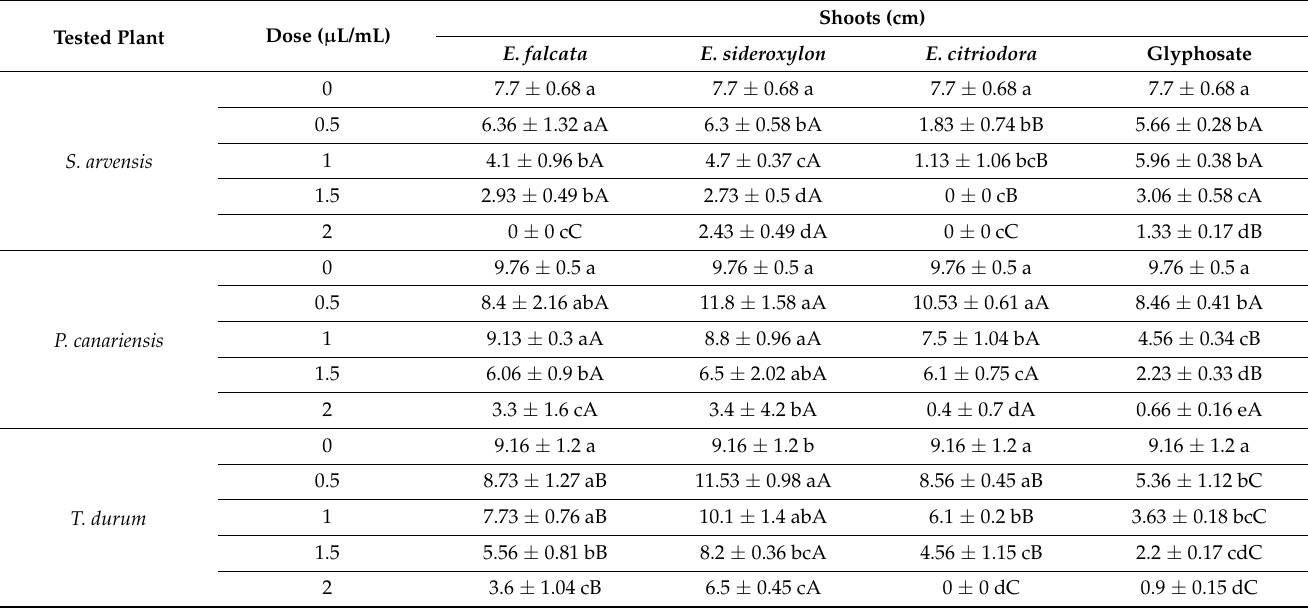
Values are means ± standard errors ( n = 3). The lowercase letters compare, in the columns, the dose effect for each herb vis- à -vis each oil. The capital letters compare, in the rows, the sensitivity of each herb at the same dose vis- à -vis the samples tested. Means followed by the same letter are not significantly different by the Student–Newman–Keuls test ( p ≤ 0.05). Table 6. Inhibitory effect of Eucalyptus species essential oils on roots growth of germinated seeds.